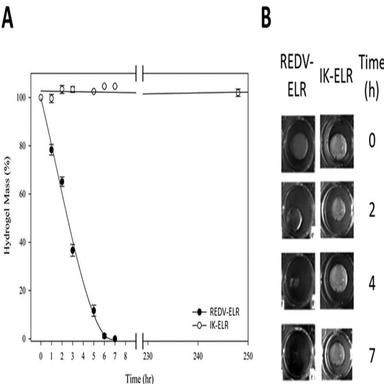
Enzymatic digestion of the ELR hydrogels was assessed by measuring the weight loss upon proteolysis. Panel A: Degradation kinetics of ELR hydrogels with (REDV-ELR) or without (IK-ELR) the elastase target sequence. Data represent the mean weight of normalized hydrogels as a percentage of total weight at time 0. Panel B: Macroscopic observation of enzymatic erosion of cross-linked ELR hydrogels.